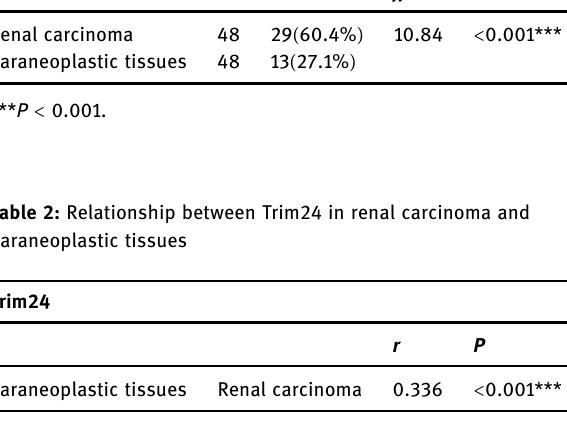
Table 1: Statistical analysis of Trim24 expression level n χ 2 P Renal carcinoma